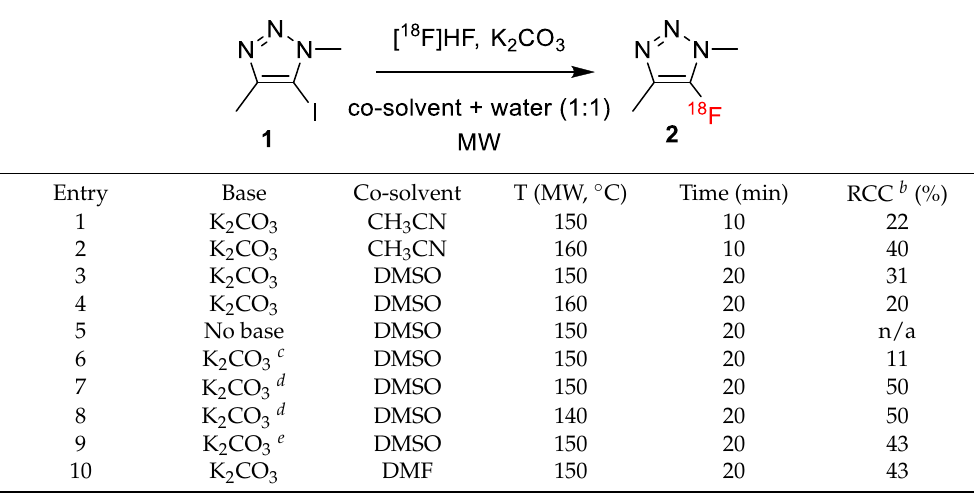
Table 1. The model reaction of aqueous [ 18 F]IFX radiofluorination a .